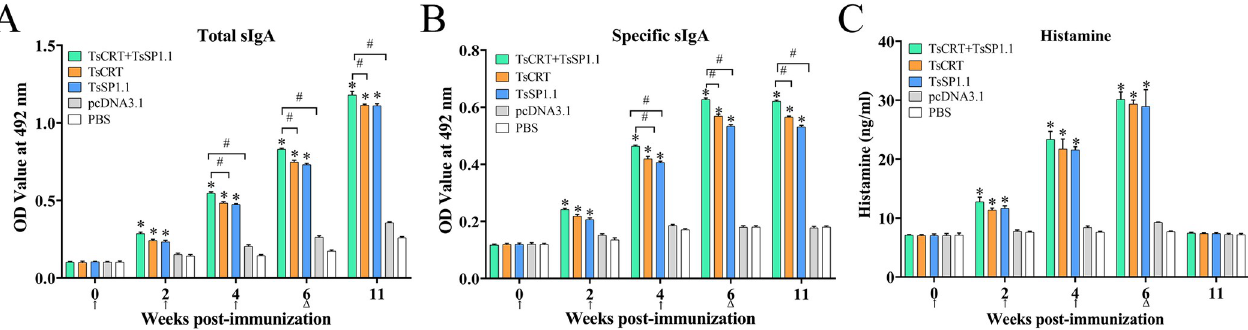
Fig 8. Levels of total sIgA (A), Trichinella -specific sIgA (B) and histamine (C) in gut washes of vaccinated mice. The data are shown as the mean OD values ± SD for five mice per group. No notable specific sIgA response was detected in the pcDNA3.1 and PBS control groups. The vaccination times are shown with arrows ( " ) and the challenge time is indicated by triangles ( 4 ). � P < 0.0001 compared with PBS group. # P < 0.001 compared among various immunization